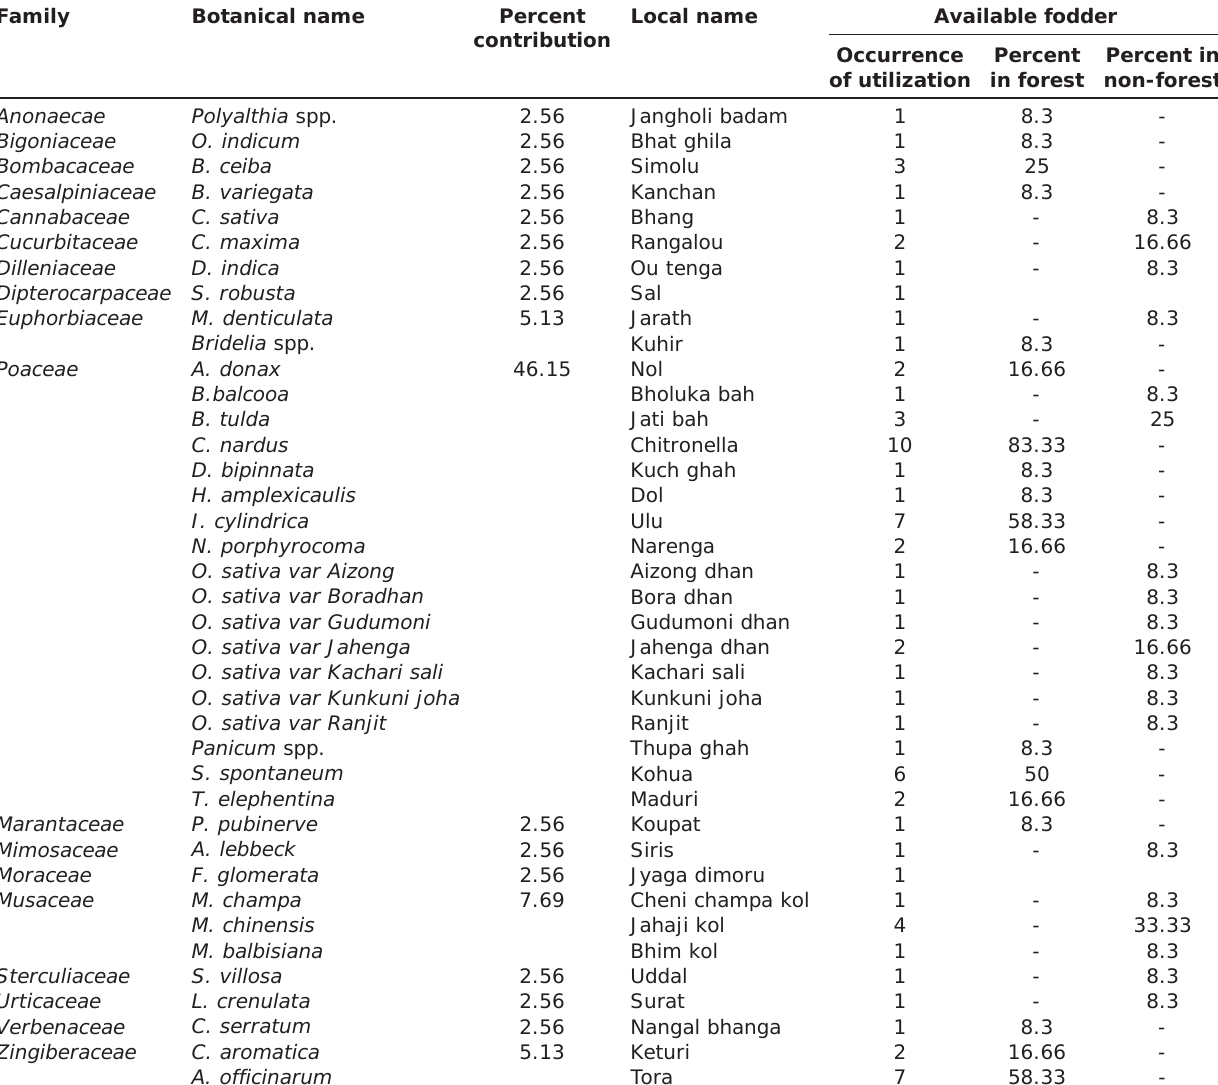
Table-5: Available fodder in forest and non-forest area and their utilization by wild Asian elephants.